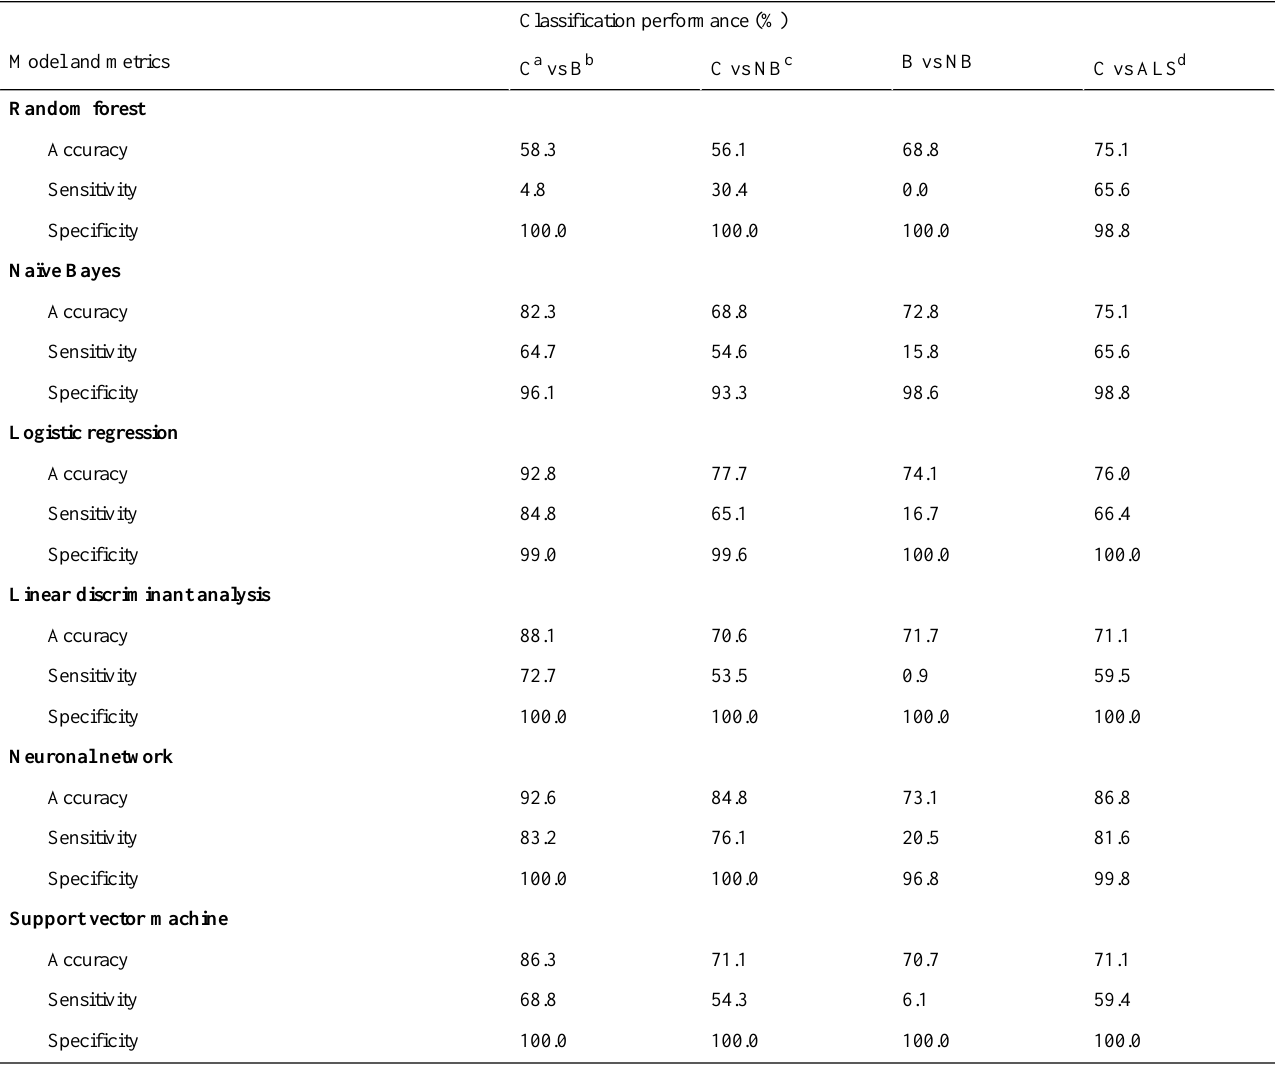
Table 2. Classification performance of the supervised models with the classification threshold set at 95%. Classification performance